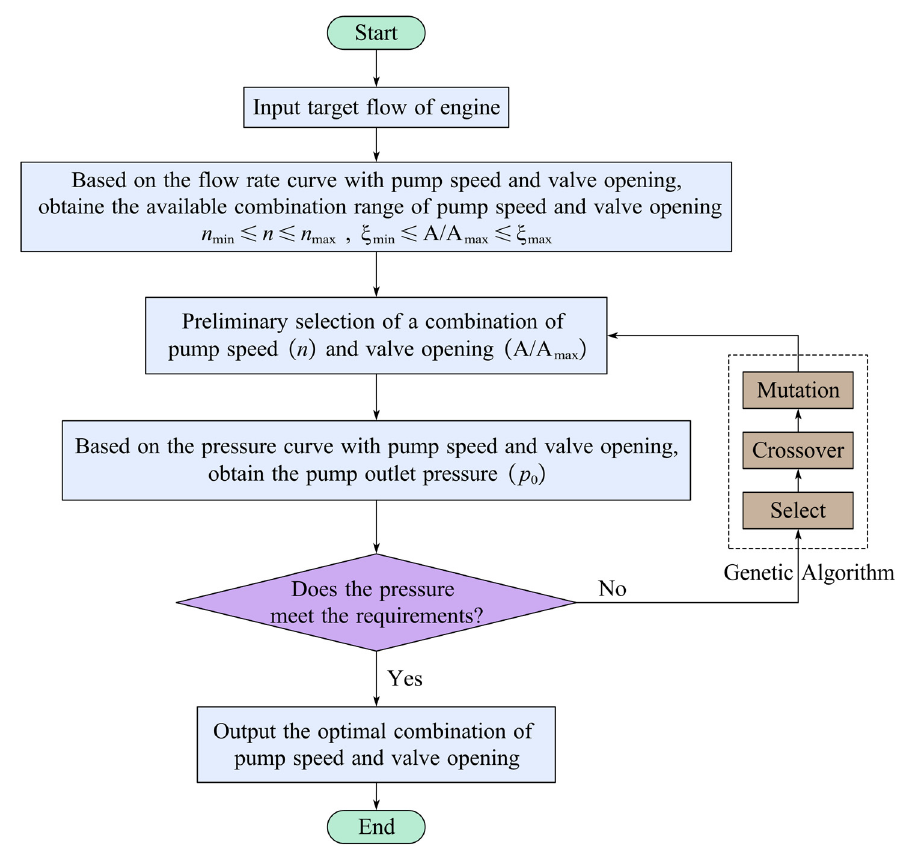
Figure 17. Calculation process of pump speed and valve opening based on genetic algorithm.